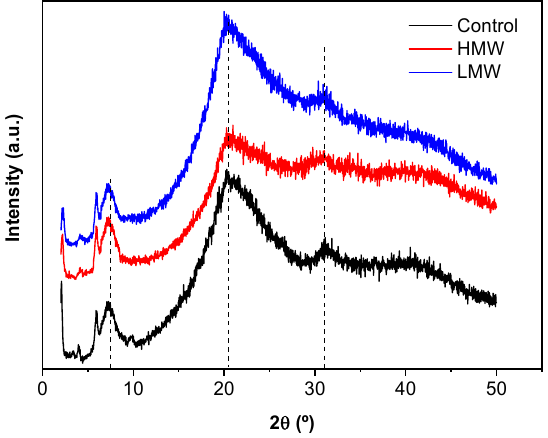
Polymers 2020 , 12 , x FOR PEER REVIEW ff olds and collagen sca ff olds with HMW and LMW chitosan. Figure 3. XRD patterns of control scaffolds and collagen scaffolds with HMW and LMW chitosan. Figure 3. XRD patterns of control sca